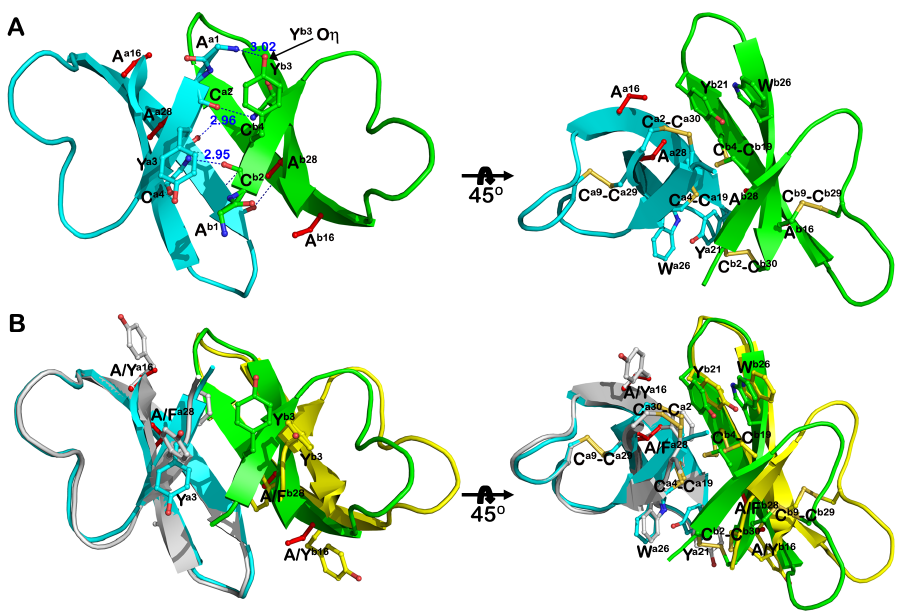
Figure 2. Dimerization of Y16A/F28A-HNP1. (A) Ribbon diagram of the Y16A/F28A HNP1 dimer with hydrophilic (left panel) and hydrophobic (right panel) residues stabilizing the dimer shown as balls and sticks. Mutated residues are shown in red and H-bonds are displayed as blue dashes. In addition to the main chain hydrogen bonds formed between Thr 18 and Ile 20 , three new hydrogen bonds, between Cys 2 and Cys 4 and between the hydroxyl of Tyr 3 and Ala 1 help stabilize the opposite face of the dimer. (B) Superposition of Y16A/F28A and wild type HNP1 dimers. Y16A/F28A is in cyan and green and wild type HNP1 in grey and yellow.